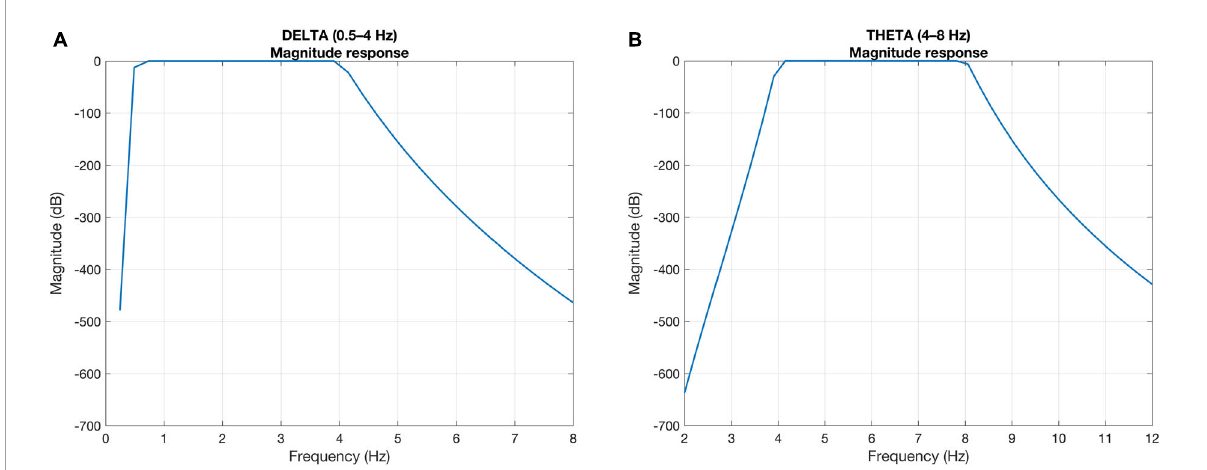
FIGURE2 Magnitude responses of the Butterworth filter showing sharper roll-off at the edge of the pass bands in (A) delta and (B) theta frequency